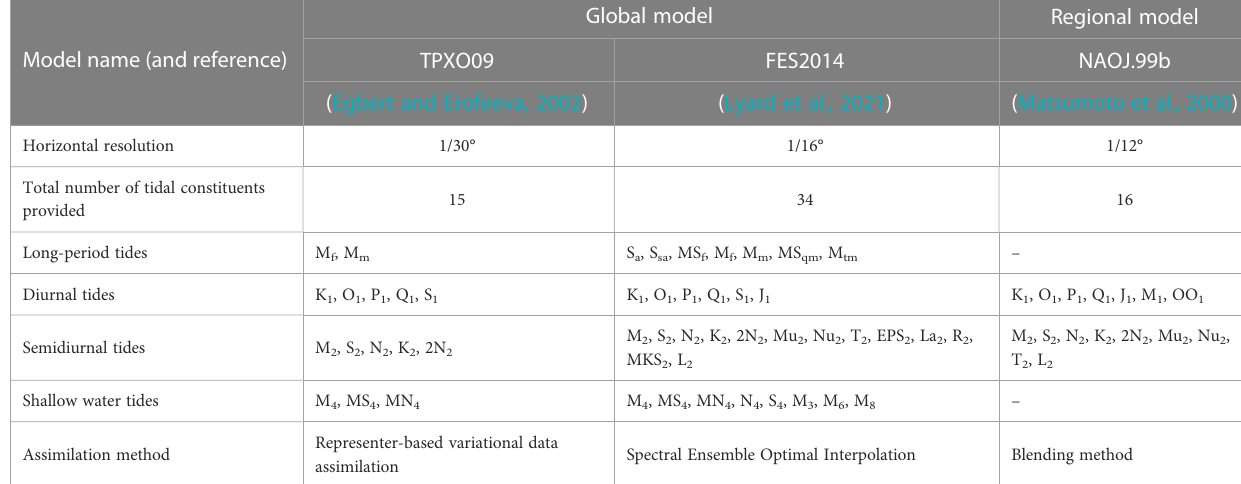
TABLE 1 Comparison of three online hydrodynamic models with data assimilation that produce open-access tidal harmonic constant databases.